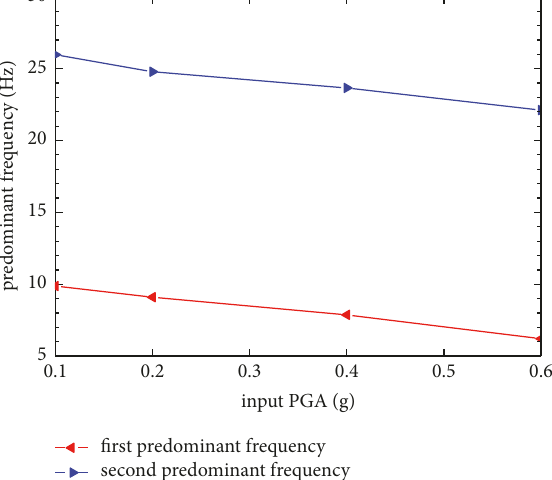
Figure 7: Predominant frequencies: (a) 0.1g; (b) 0.2g; (c) 0.4g; (d) 0.6g.